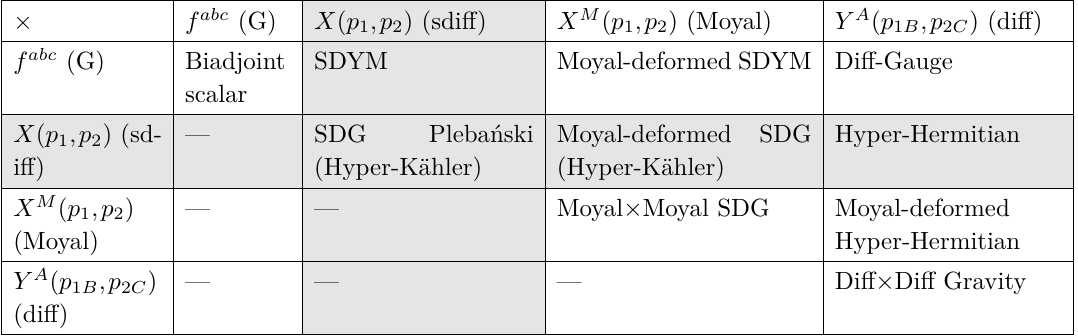
Table 1 . The web of theories studied in this paper. Each theory has an integral equation containing two structure constants, appearing on the left-hand and upper entries of the table. We represented in grey the theories that are